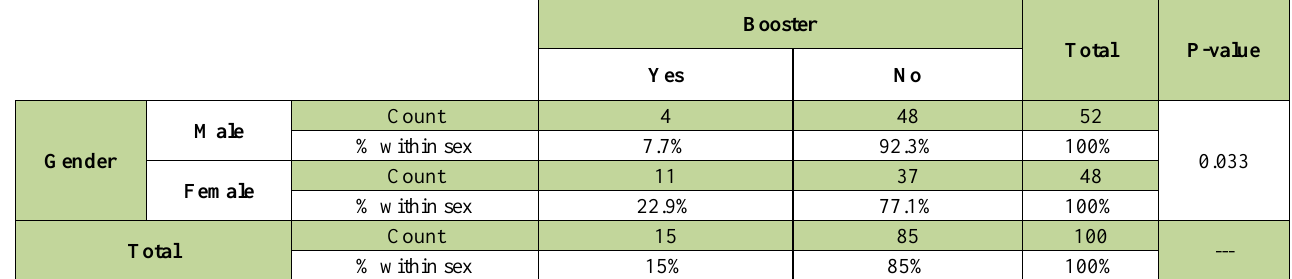
Table 4. Frequency of samples in terms of receiving a reminder dose by gender.